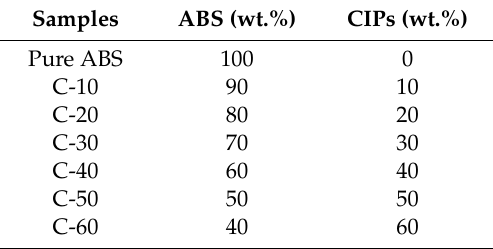
Table 2. Description of CIP / acrylonitrile-butadiene-styrene copolymer (ABS) composites. Samples ABS (wt.%) CIPs (wt.%) Pure ABS 100 0 C-10